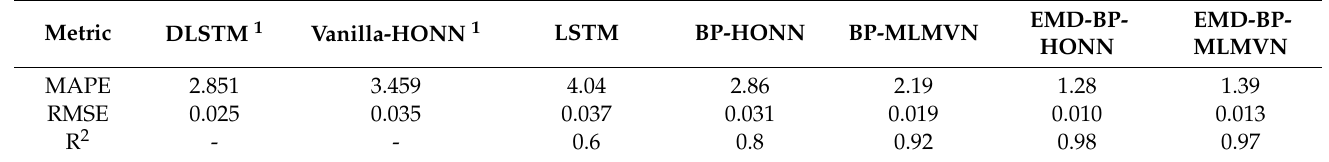
Table 8. Comparison to other study for cumulative production of Cambay Basin